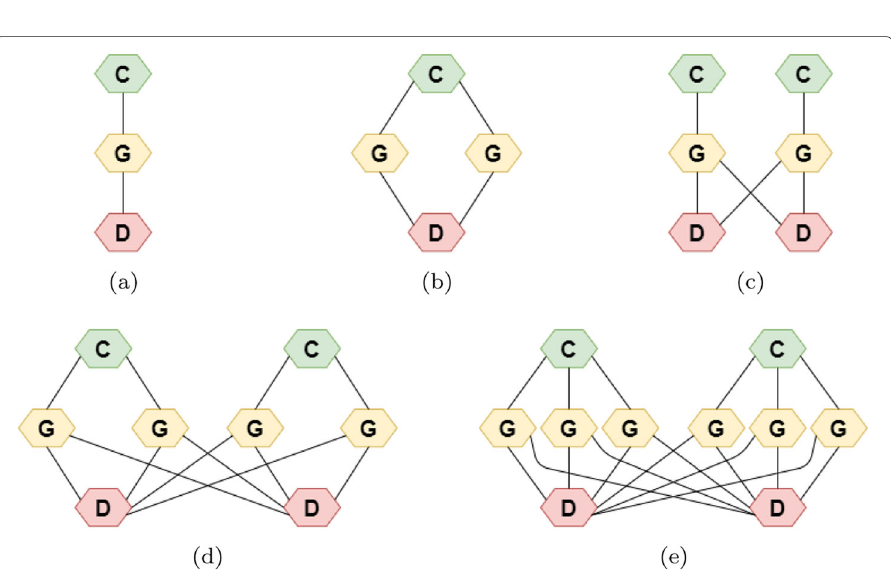
Fig. 13 Motif graphs of the Hetionet network with 3 nodes ( a ), 4 nodes ( b ), 6 nodes ( c ), 8 nodes ( d ) and 10 nodes ( e ). Node names are C for Compounds, G for Genes and D for